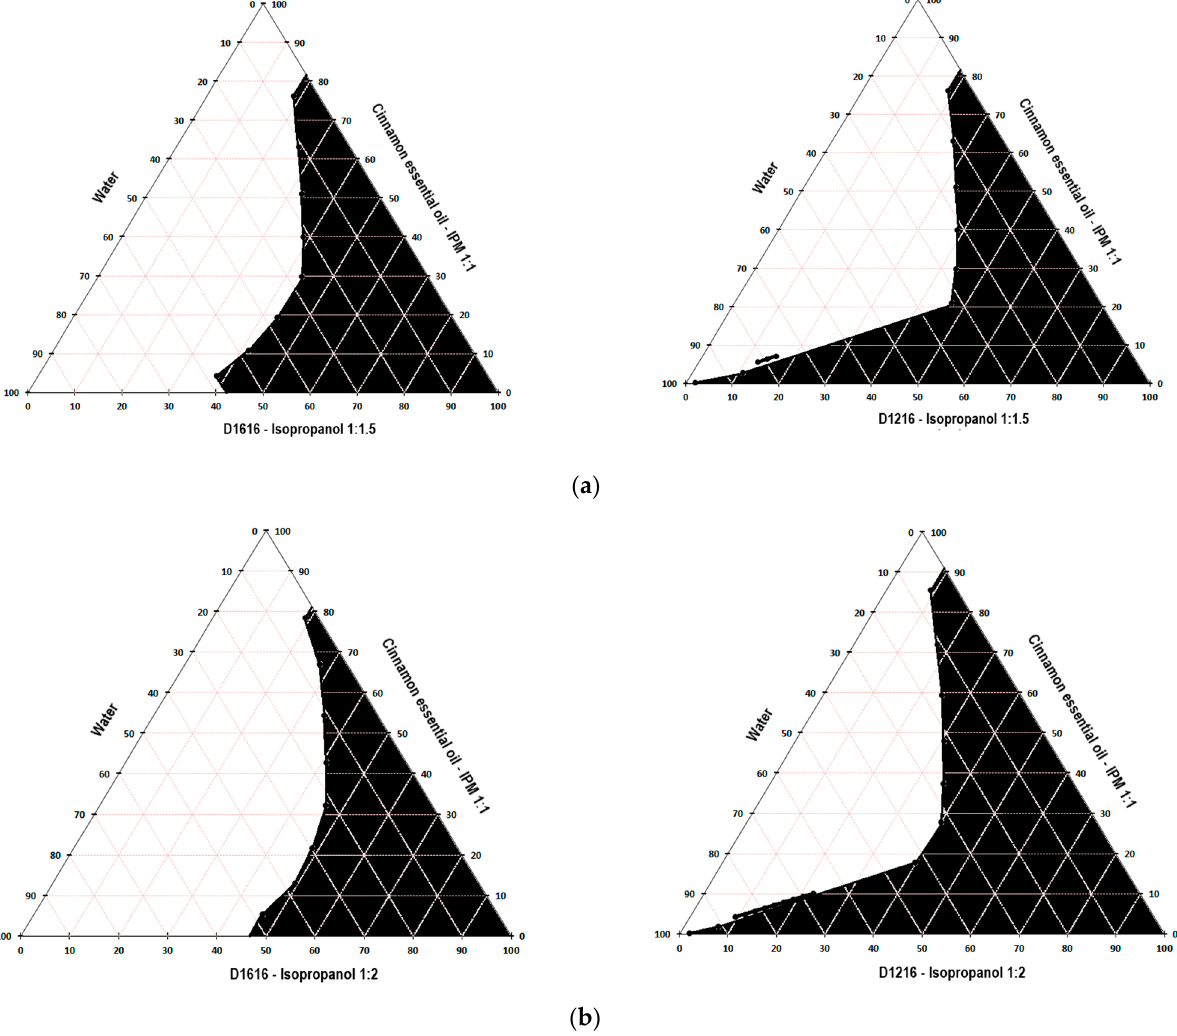
Figure 1. Pseudo-ternary phase diagrams for the cinnamon essential oil/IPM– D1616/IPA –water and cinnamon essential oil/IPM– D1216/IPA –water systems, for S mix 1:1.5 ( a ) and 1:2 ( b ).